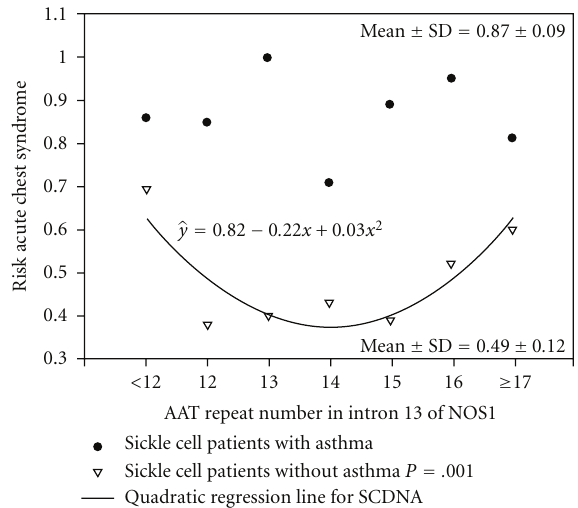
Sickle cell patients without asthma P = . 001 Figure 2: Risk of ACS and NOS1 AAT repeats in intron 13. The risk of ACS (1-[controls/(cases+controls)]) is plotted against the number of NOS1 AAT repeats in patients with SCD with physician- diagnosed asthma (closed circles) and without physician- diagnosed asthma (SCDNA). ACS: acute chest syndrome, NOS1: nitric oxide synthase 1 gene, SCDNA: sickle cell disease physician diagnosed asthma, reproduced with permission from